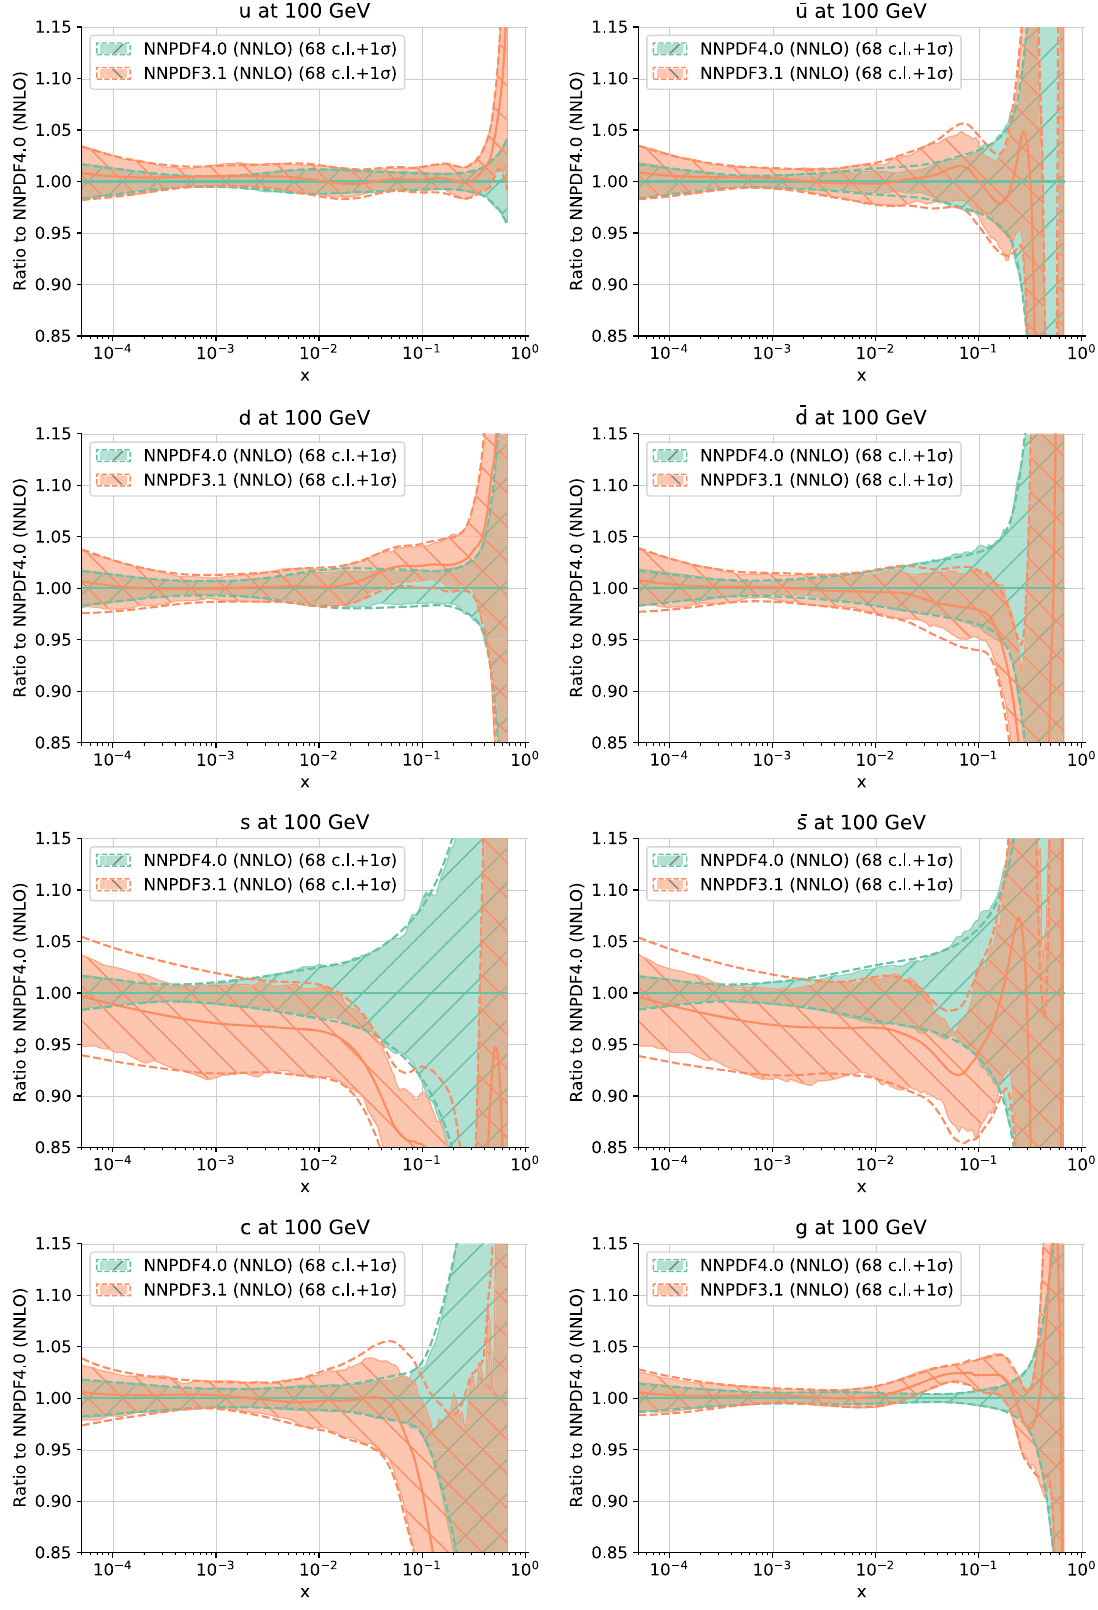
Fig. 17 The full set of NNLO NNPDF4.0 PDFs: the up, antiup, down, antidown, strange, antistrange, charm and gluon PDFs at Q = 100 GeV, compared to NNPDF3.1. Results are normalized to the central NNPDF4.0 value. Solid and dashed bands correspond to 68% c. l. and one-sigma uncertainties,